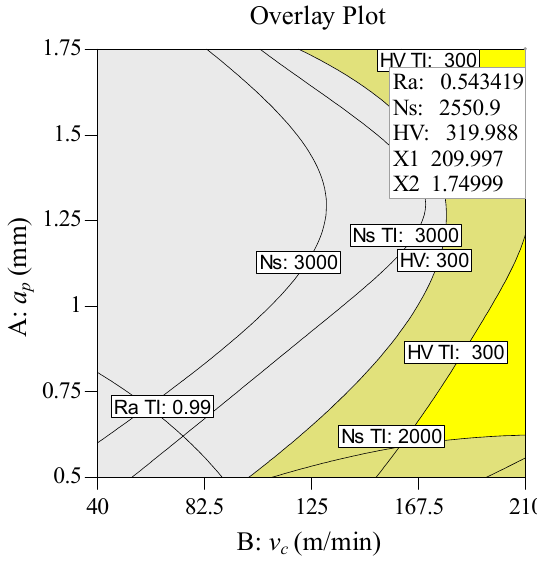
Figure 19. Overlay contour plot for multi-response (LSR mode).